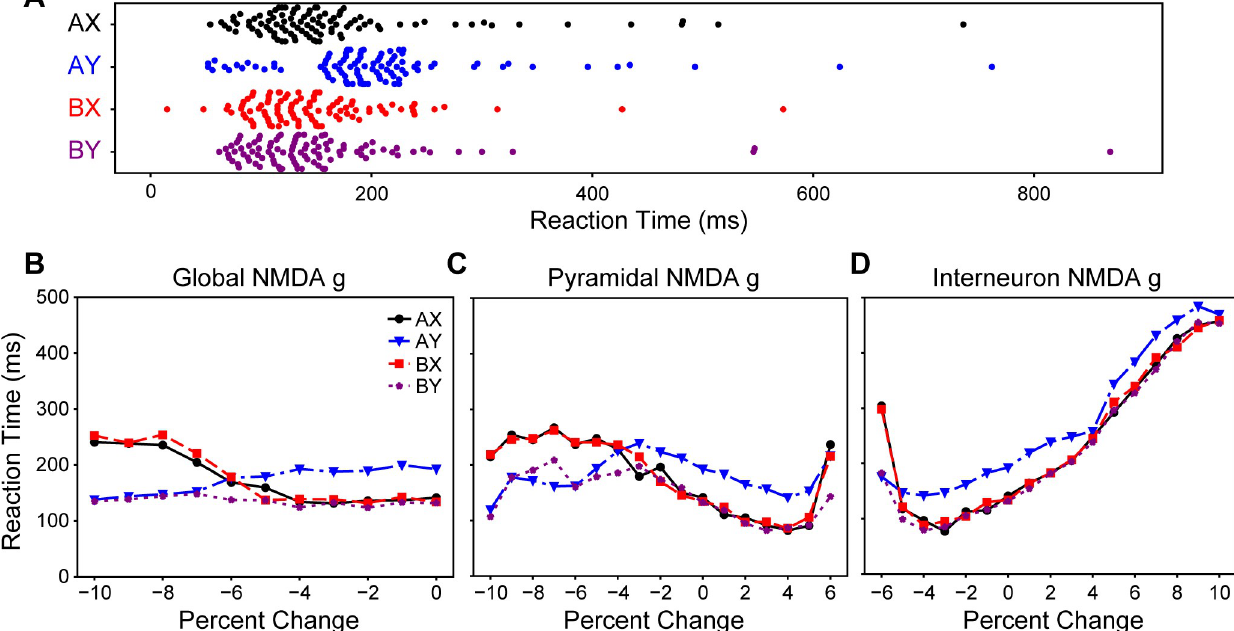
Fig 6. EI balance affects the agent’s reaction times. A. Swarm plots of the neurotypical agent’s reaction times during the four trial types. As is in the DPX task literature, there was a delayed response on AY trials. B. Reaction times bifurcated as the NMDA conductance of all cells was reduced. The reaction times separated by the probe. C. Reaction times also bifurcated as the pyramidal cell NMDA conductance was reduced, but increased across all trial types as it approached a 6% increase in pyramidal NMDA conductance. D. Reaction times of all trials increased as the NMDA conductance on interneurons increased, and also increased as it reached a 6%